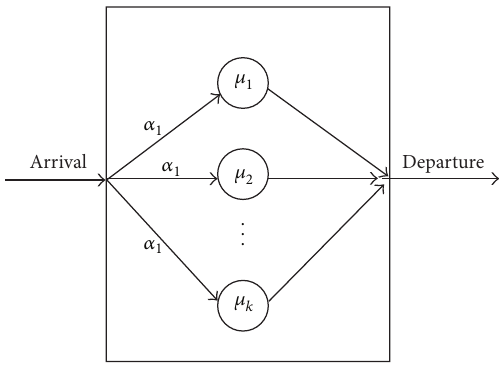
Figure 2: Schematic representation of hyperexponential service facility with 𝑘